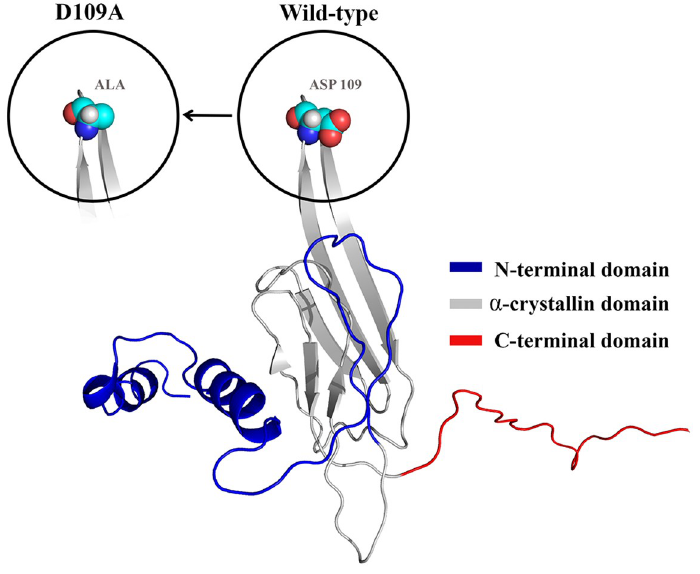
Fig 1. The domain organization of human α B-crystallin and position of D109A mutation in structure of this protein (PDB ID: 3J07).